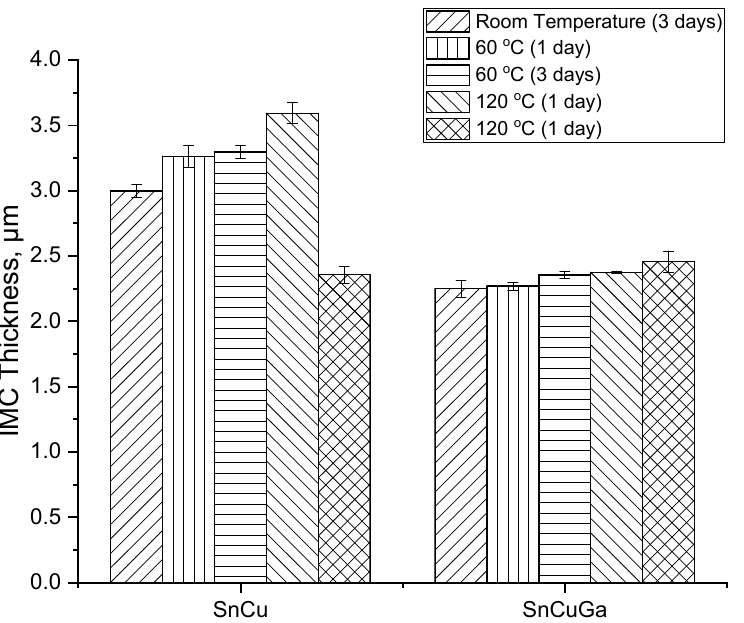
Figure 7. Average total IMC thickness of Sn–0.7Cu and Sn–0.7Cu–0.05Ga exposed by electromigration and thermal ageing at the anode side.